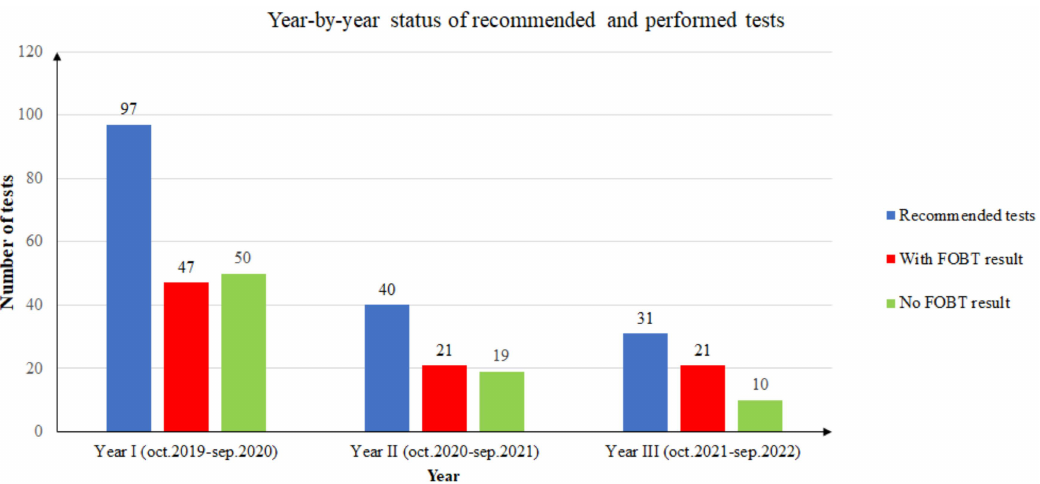
Figure 2. Year-by-year status of recommended and performed tests.